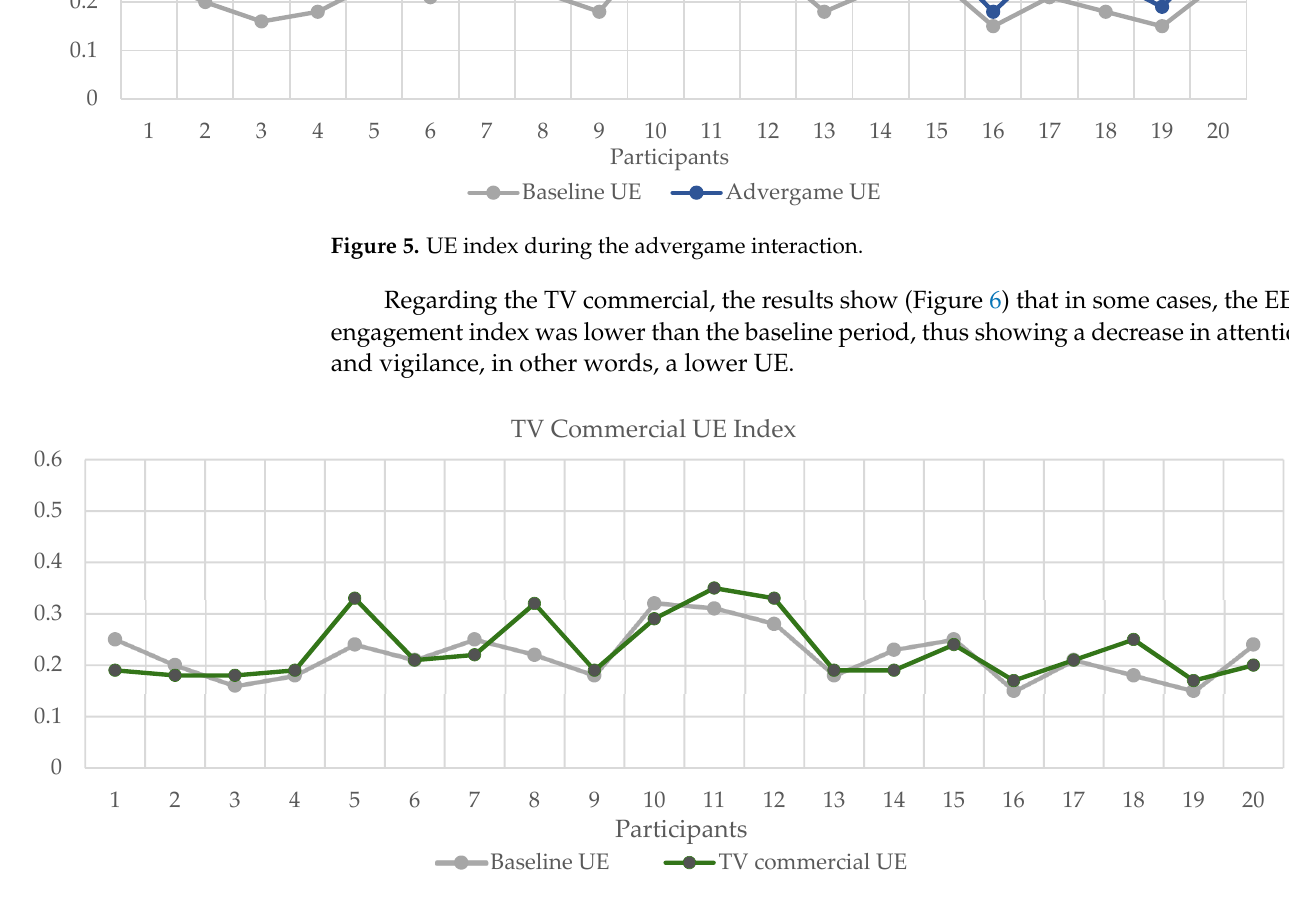
Figure 6. UE index during the TV commercial.